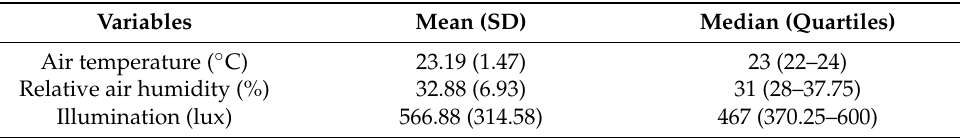
Table 3. Results of measurements of temperature, relative air humidity, and lighting intensity in hospital rooms during the study